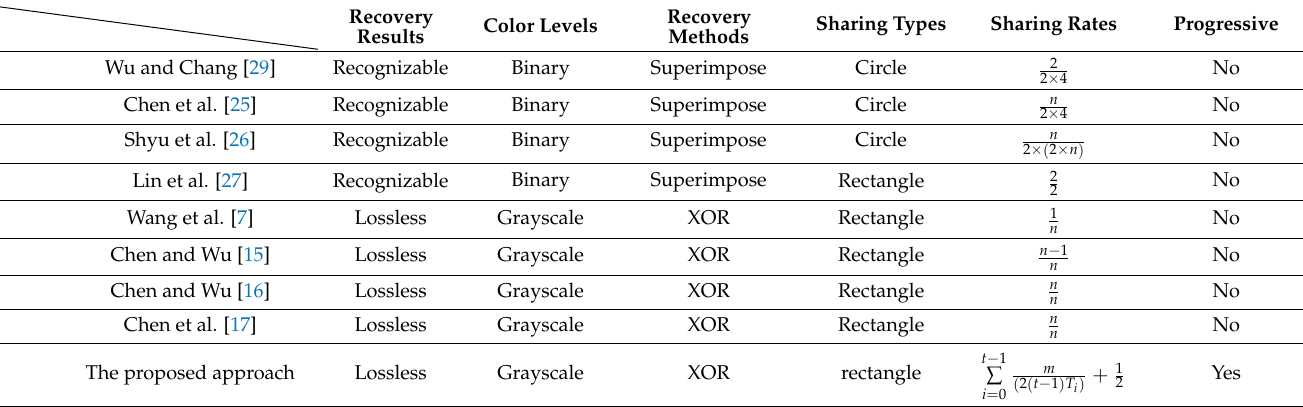
Table 3. Comparisons between the proposed approach and related multiple secret image sharing